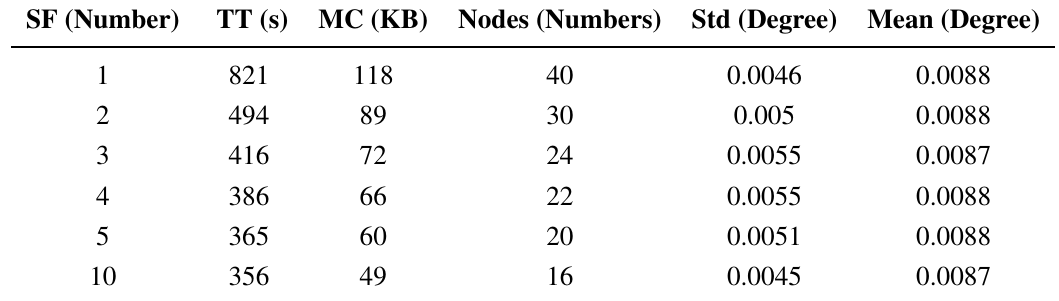
Data features of the non-separating method for post-compensated data (TT denotes training time, MC denotes memory cost, KB denotes one thousand bits, SF denotes separating factor, Std denotes the standard deviation).